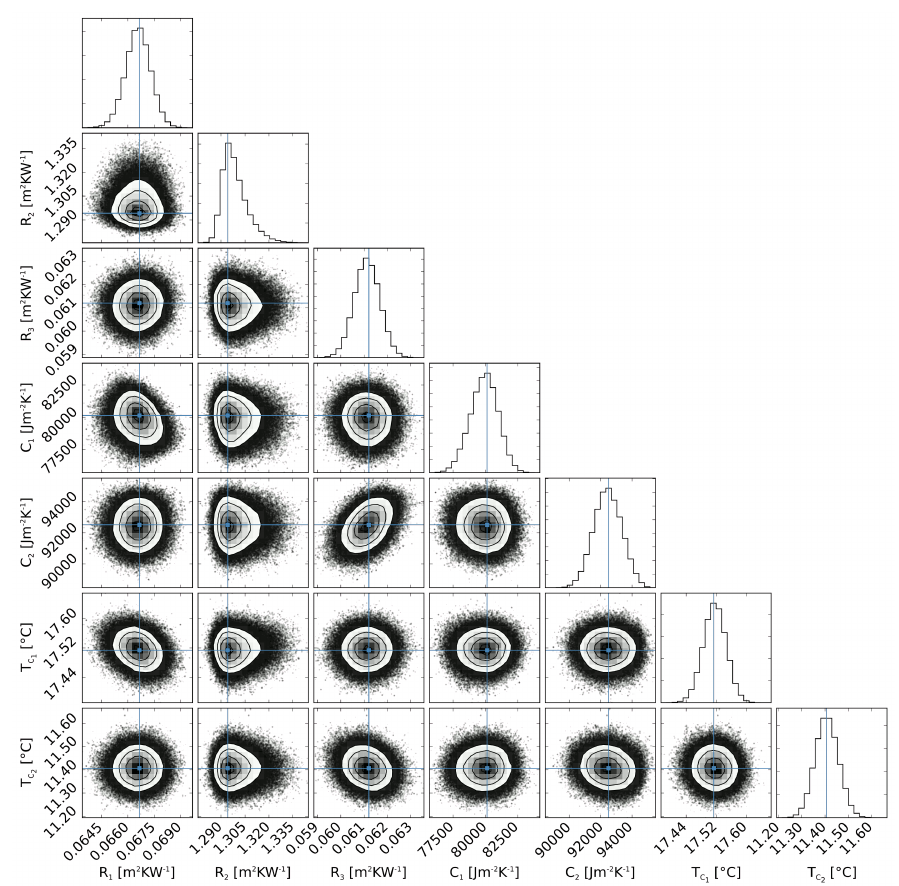
Figure 7. Corner plot of the distribution of the thermophysical properties of the CWall_N using the 2TM model. The turquoise crossed lines indicate the maximum a posteriori (MAP) estimation used as starting point for the Markov chain Monte Carlo (MCMC) walk.